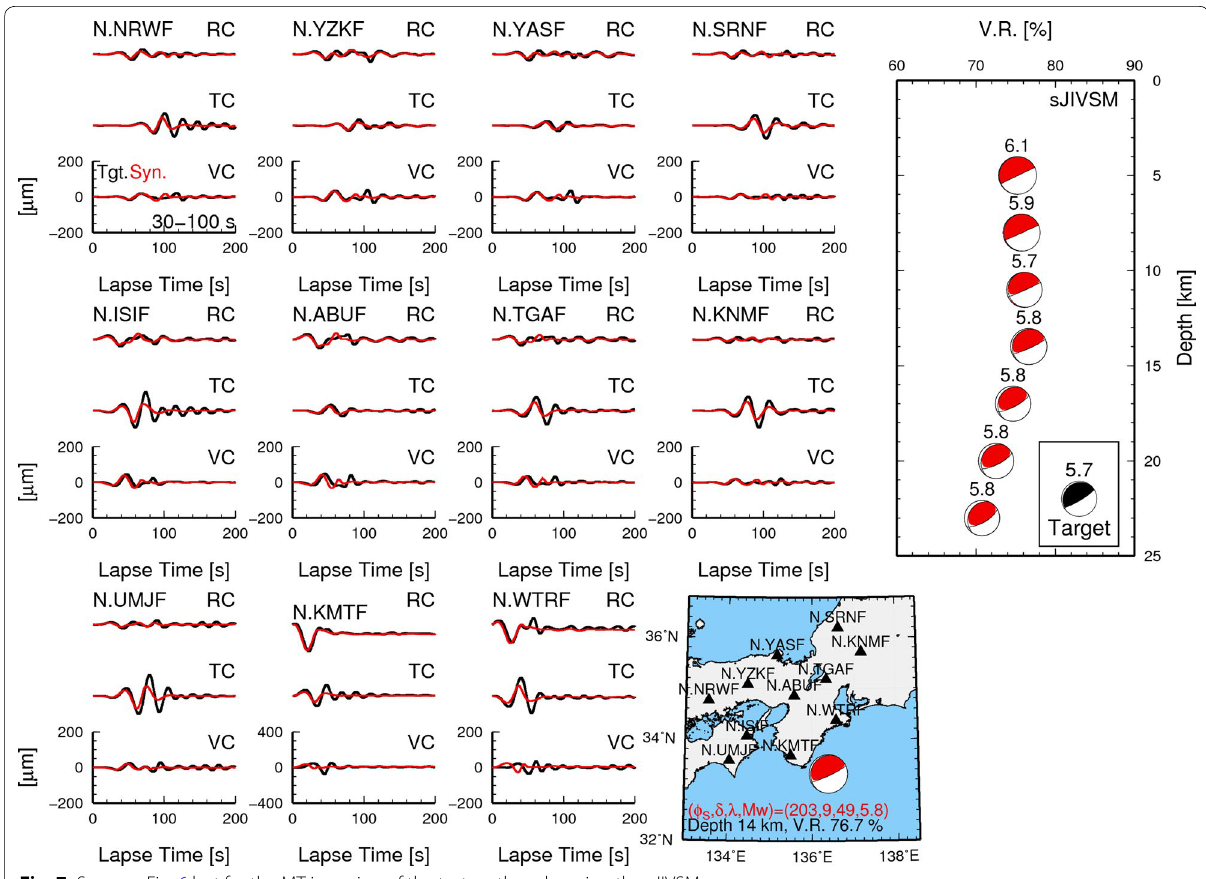
Fig. 7 Same as Fig. 6 but for the MT inversion of the test earthquake using the